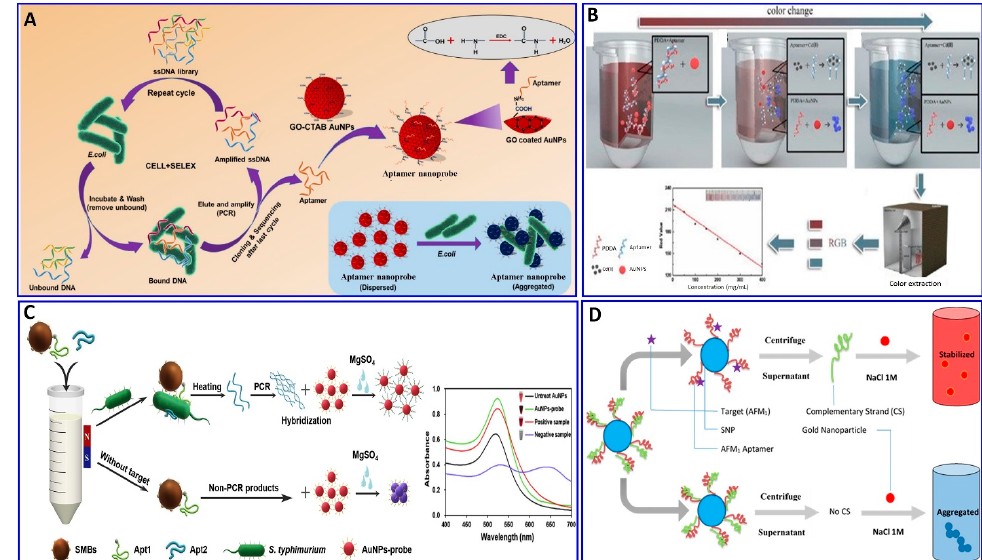
Figure 1. ( A ) Schematic illustration of the colorimetric aptamer sensor for E. Coli assay via target inducing aggregation of gold nanoparticles (AuNPs), reproduced from [84]. ( B ) Schematic illustration of the colorimetric aptasensor for Cd 2+ assay based on AuNP aggregation, reproduced from [86]. ( C ) Schematic procedure for an S. typhimurium bacterium assay via a proposed colorimetric SMBs-Apt1 sandwich strategy, reproduced from [87]. ( D ) Schematic illustration of a colorimetric aptasensor assay for AFM1 based on salt aggregation of AuNPs induced by AuNP–aptamer competitive binding, reproduced from [89].